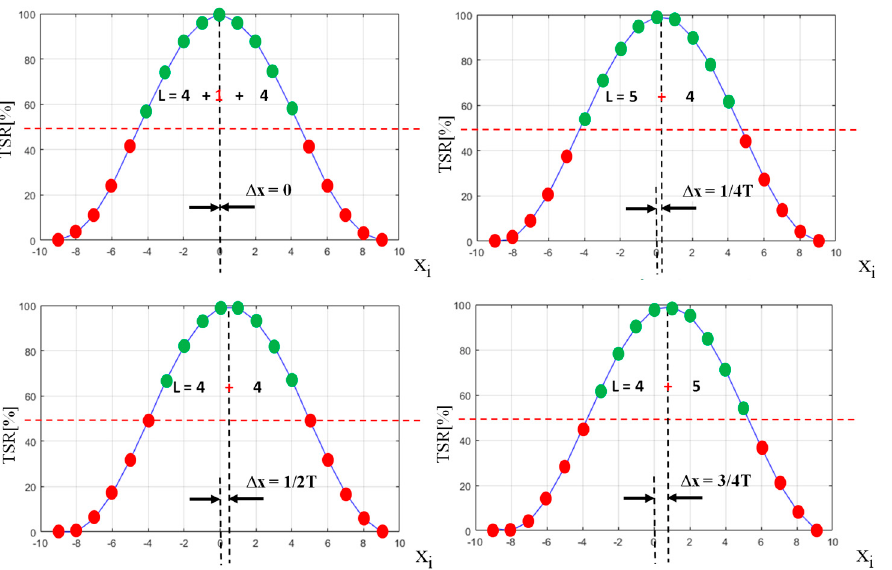
Figure 7. Visualization of results of threshold detection method used on pulses generated with different time delay ∆ x between their peak and moments of sampling ( TSR —threshold to signal ratio).